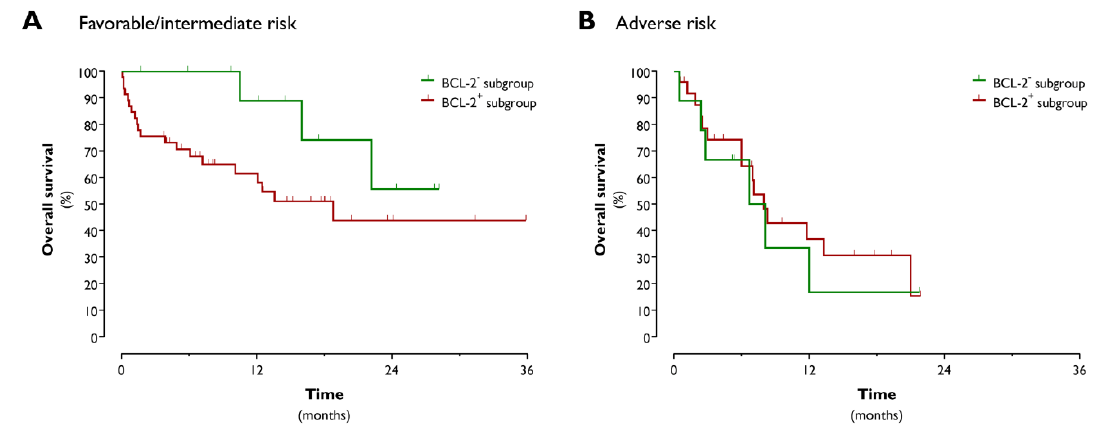
Figure 3. Kaplan–Meier overall survival curves of favorable / intermediate ( A ) and adverse ( B ) risk BCL-2 − and BCL-2 + AML patients.